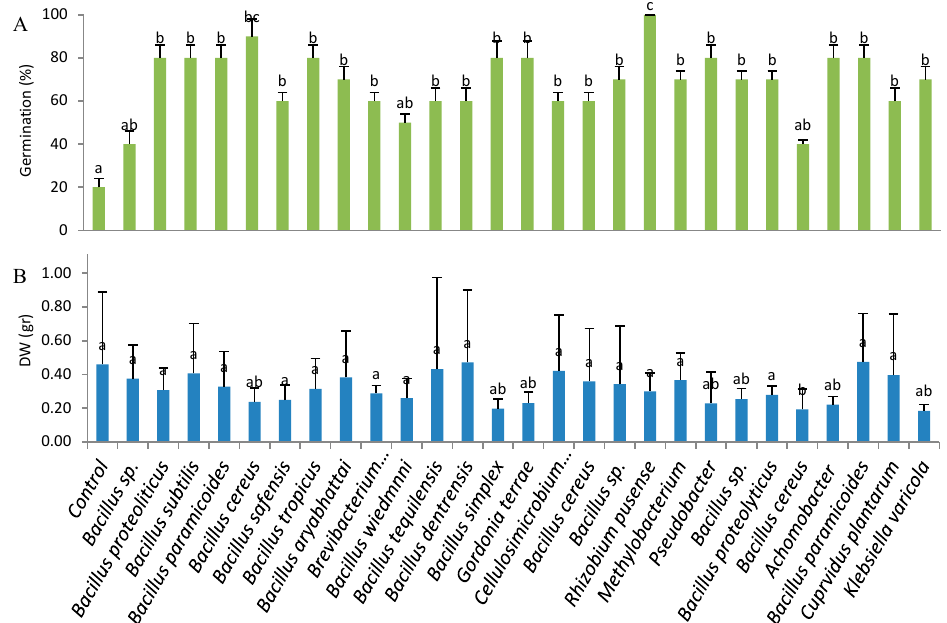
Figure 3. ( A ) Germination percentage of seeds of H. annuus inoculated with individual strains and ( B ) biomass development as total dry weight (DW) of plant per plate after two weeks of incubation in VAP systems. Error bars are S.E. ( n = 15); Values followed by the same letter(s) are not significantly different at p ≤ 0.05 by Anova and Tukey test.